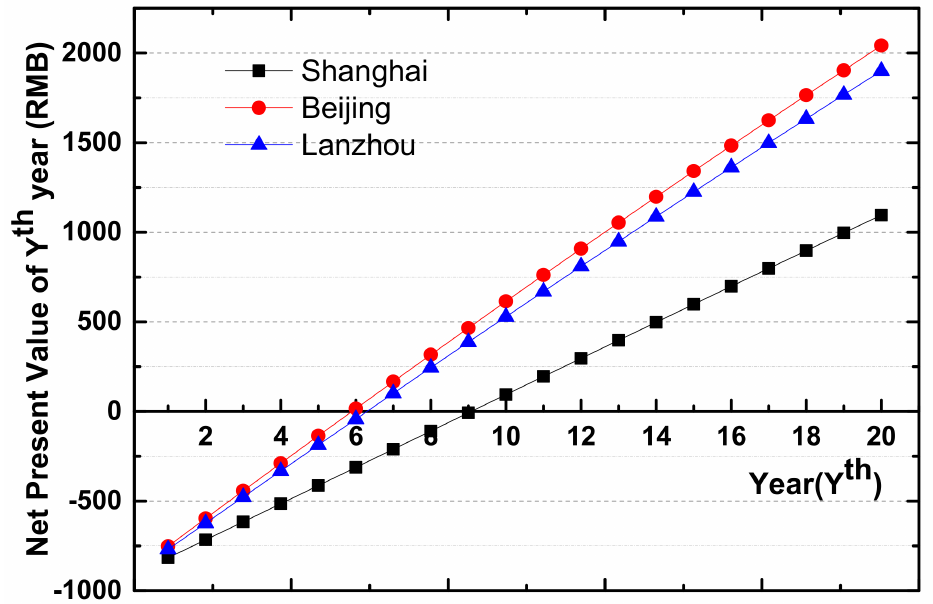
The life-cycle savings of the ASTF system are 1232.7 RMB/m 2 , 2065.8 RMB/m 2 and 1923.4 RMB/m 2 for Shanghai, Beijing and Lanzhou, respectively. Figure 11 show the net present values (NPV) from the 1st year to the 20th year. The NPV change from negative to positive at the time of the ninth year, sixth year and sixth year for Shanghai, Beijing and Lanzhou, respectively. Therefore, the discounted payback period of the ASTF system is 9 years, 6 years and 6 years for Shanghai, Beijing and Lanzhou, respectively.